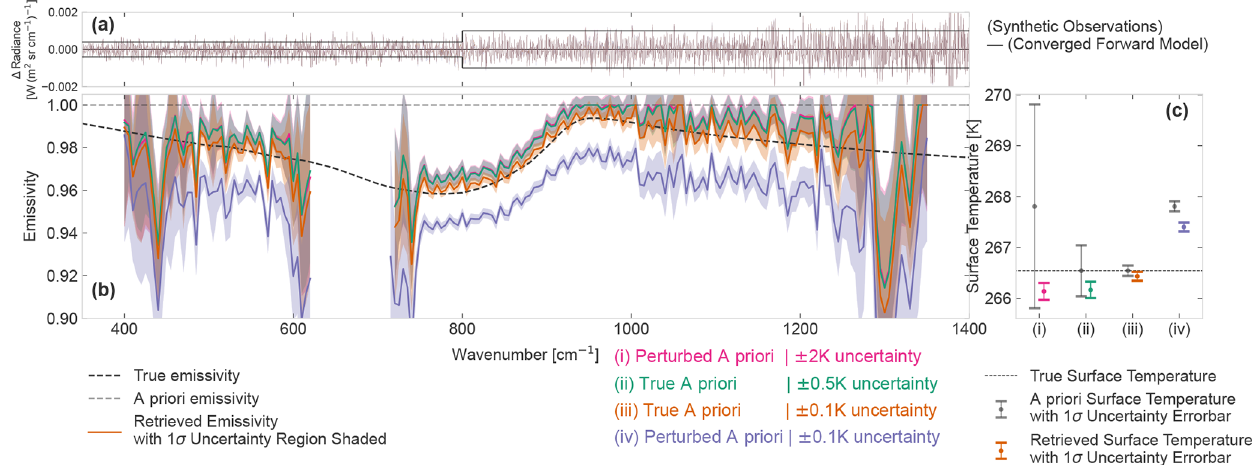
Figure 7. Different constraints on the surface temperature retrieval. Panel (b) shows the retrieved emissivity with the ± 1 σ retrieval un- certainty range shaded in the same colour. Panel (c) shows the retrieved surface temperatures with ± 1 σ retrieval uncertainty for the same retrieval runs as panel (b) . Panel (a) shows the difference between the same synthetic observations and the four different converged forward models. The four cases are detailed in the text, and the retrievals are pink, green, orange and purple for cases (i), (ii), (iii) and (iv), respec- tively. Note that the scale in panel (b) only shows the emissivity from 0.9–1.0, and that even the wrongly constrained case (iv) only results in an uncertainty on a scale of ∼